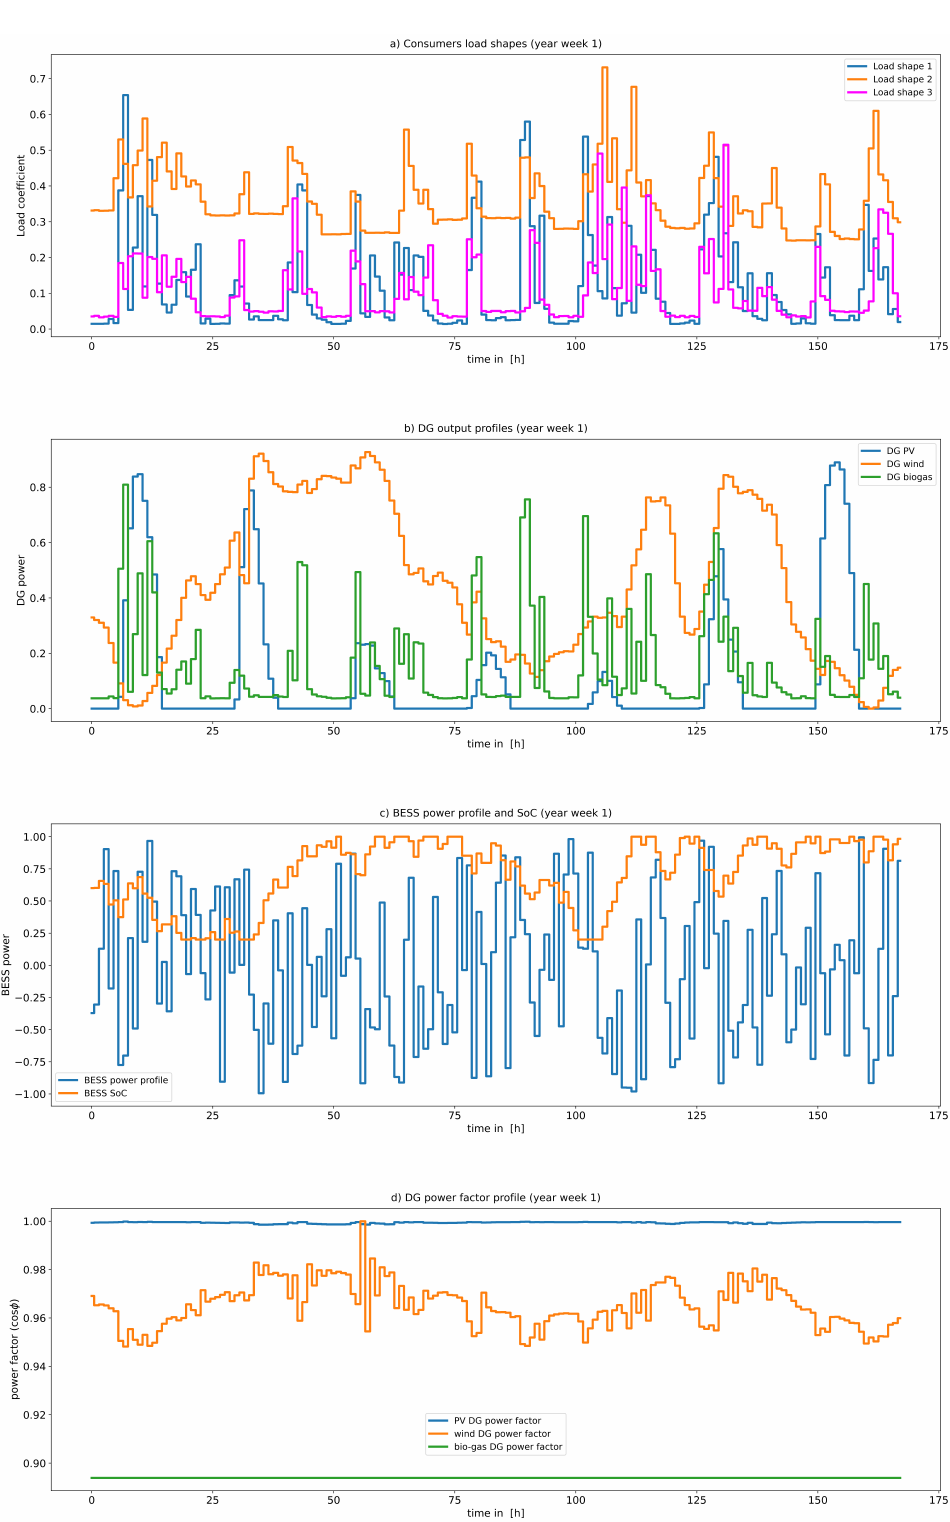
Figure 5. Load, DG and BESS profiles for 1st week in year: ( a ) Consumers load shapes, ( b ) DG output profiles, ( c ) BESS power profile and SoC, ( d ) DG power factor